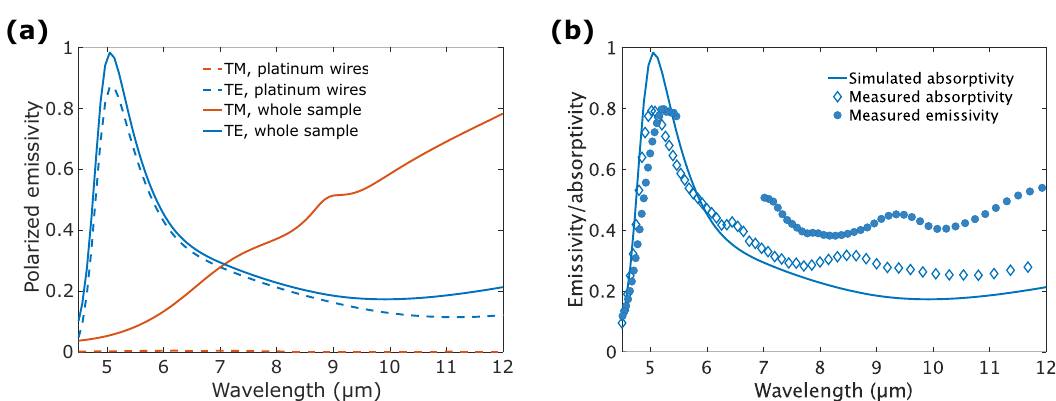
Fig. 3 Simulated and measured emissivity spectra of the device. a RCWA-calculated polarized emissivity spectrum of the metallic wires (dashed) and of the whole sample (thick lines) at angle 17.5°. b Measured emissivity spectrum. Thick line: theoretical TE polarized absorptivity of the device under 17.5° incidence simulated using RCWA. Diamonds: measured TE polarized absorptivity via re fl ectivity-measurement on a FTIR microscope with a 15× Cassegrain objective (NA = 0.58) using a globar source and a polarizer. Filled dots: measured TE polarized emissivity spectrum rescaled such that the peak value matches the one of the absorptivity. Systematic errors due to air absorption occurred in the calibration of the spectral response of the detector so that data are removed in the [5.5 μ m; 7 μ